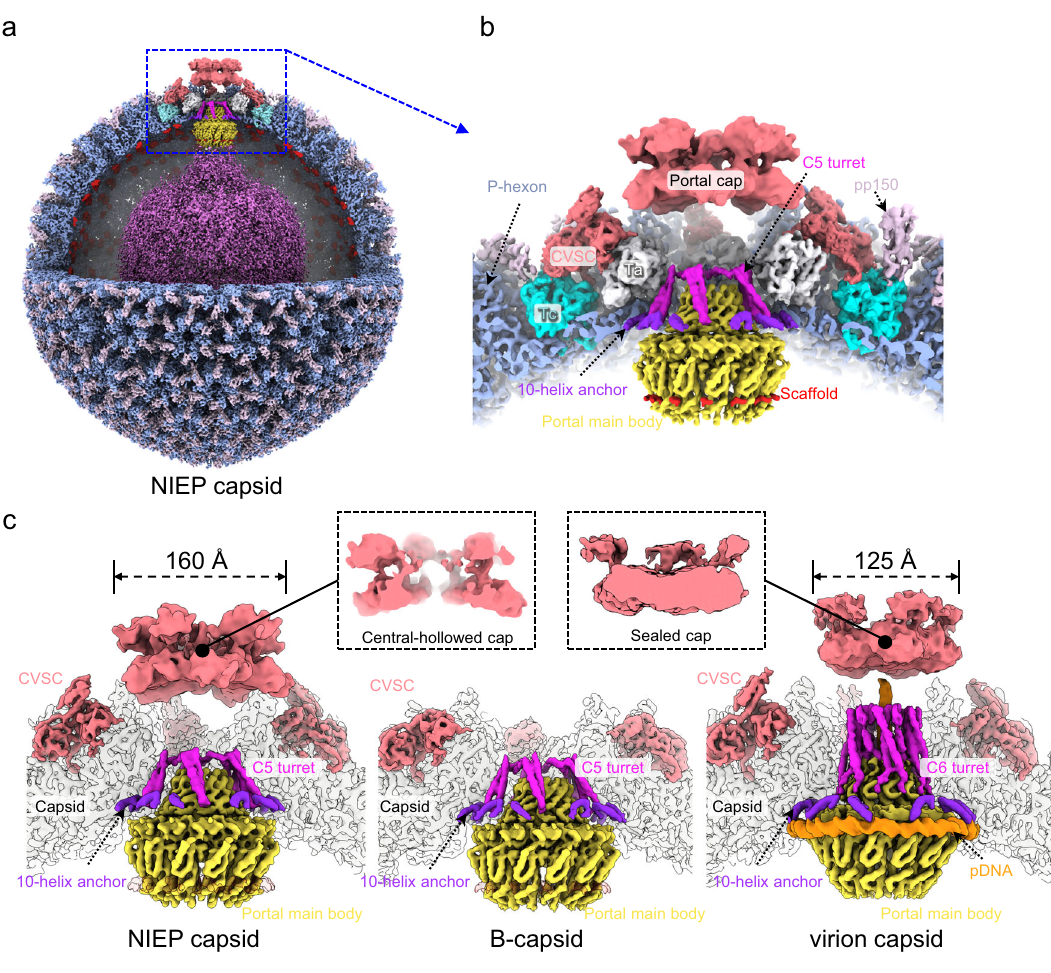
Fig. 6 | Asymmetric reconstructions of capsids and in situ portal of NIEP cap- sids.a CompositemapoftheasymmetricstructureoftheNIEPcapsid.Upper-front quarter of the capsid and the outer scaffold shell are removed to show the portal vertex and inner capsid materials. The composite map is assembled from recon- structions of C1 capsid (capsid, light blue; pp150, pink), C5 portal vertex (CVSC, salmon; Ta, white; Tc, cyan; portal turret, magenta and 10-helix anchor of portal,